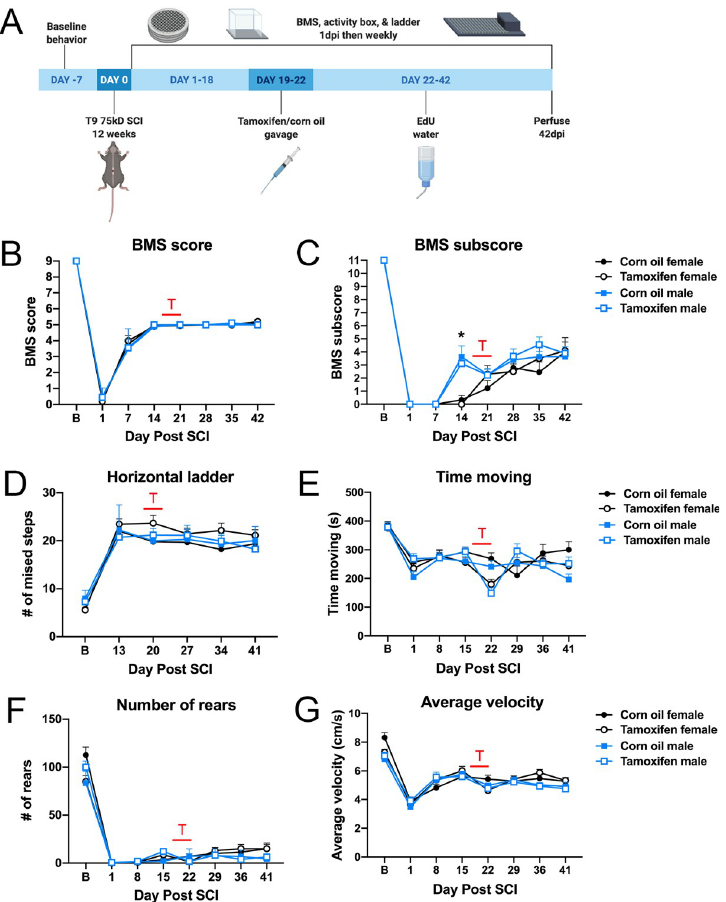
Fig 2. Motor recovery is unaffected by delayed tamoxifen administration. (A) Schematic of experimental timeline. (B-G) T indicates when animals received tamoxifen or corn oil gavage. (B) BMS scores were not different between sexes or tamoxifen and control mice at any time post-injury. (C) BMS subscores were significantly increased 14dpi in male mice compared to females, but sex did not impact subscores after gavage. BMS subscores were unaffected by tamoxifen. (D) The number of missed steps on the automated horizontal ladder was not statistically significant between groups. (E) Tamoxifen gavage reduced the number of ambulatory activities at 22dpi in female and male mice. Ambulation of tamoxifen mice recovered by 29dpi. (F-G) (F) The number of vertical rears or (G) speed of ambulation was not different between groups over time. (B-F) Two-way repeated measures ANOVA with Sˇı´da´k post hoc test; corn oil female n = 9; tamoxifen female n = 10; corn oil male n = 8; tamoxifen male n = 9; � p < 0.05.